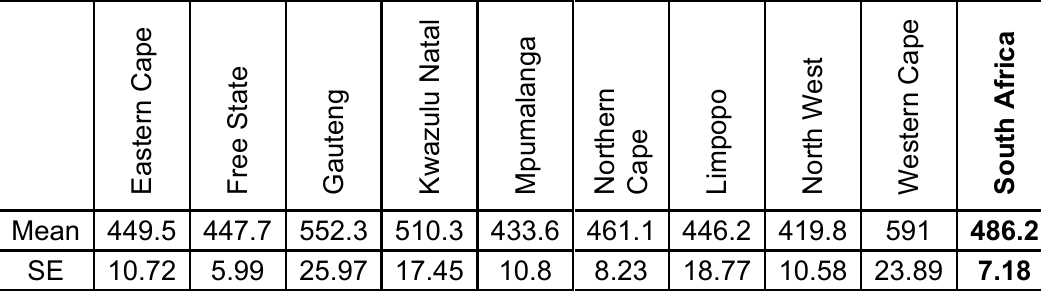
Table 1. Overall mathematics performance (SACMEQ II Research Report, n.d.)